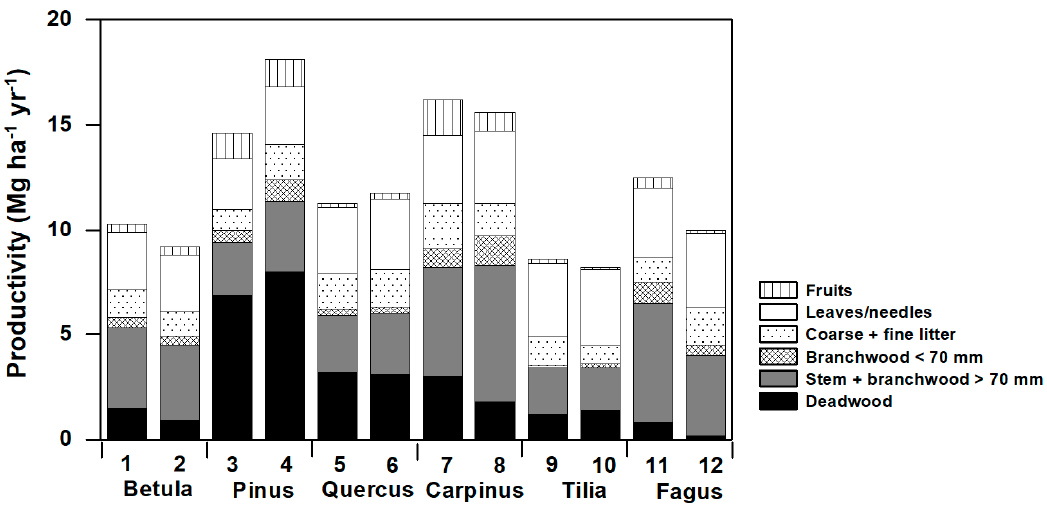
Figure 6. Aboveground productivity (dry mass) of the 12 stands of six tree species in 1999 by fraction. Coarse and fine litter was collected with two different litter bucket types. The production of deadwood refers to the calculated increase in dead branch mass in the trees.